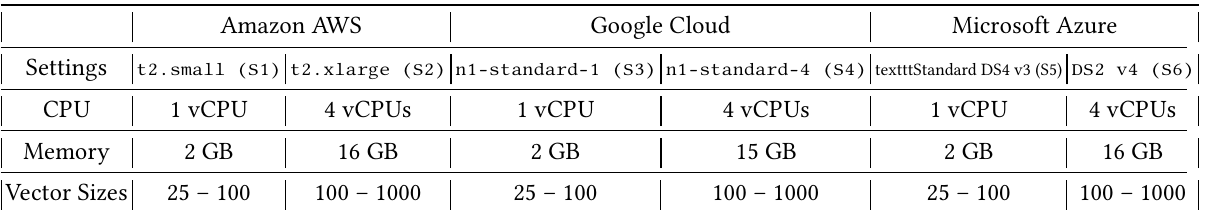
Table 2. System Configurations of VMs on Different Cloud Infrastructures